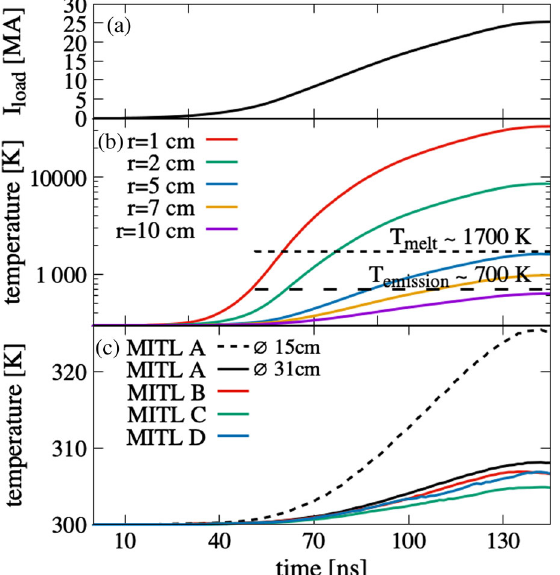
FIG. 8. (a) The current pulse delivered to the load without losses. (b) Electrode surface temperatures at various radii in the inner MITL calculated using Eq. (1) and the pulse in (a). (c) Electrode surface temperatures calculated at the inner radius of each outer MITL as labeled in Fig. 3. The ∅ 31 cm convolute is represented by solid lines. The ∅ 15 cm is represented by a dashed